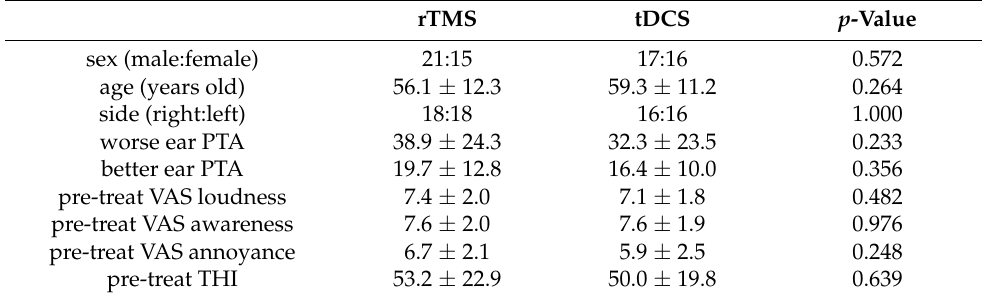
Table 1. Demographic data of enrolled